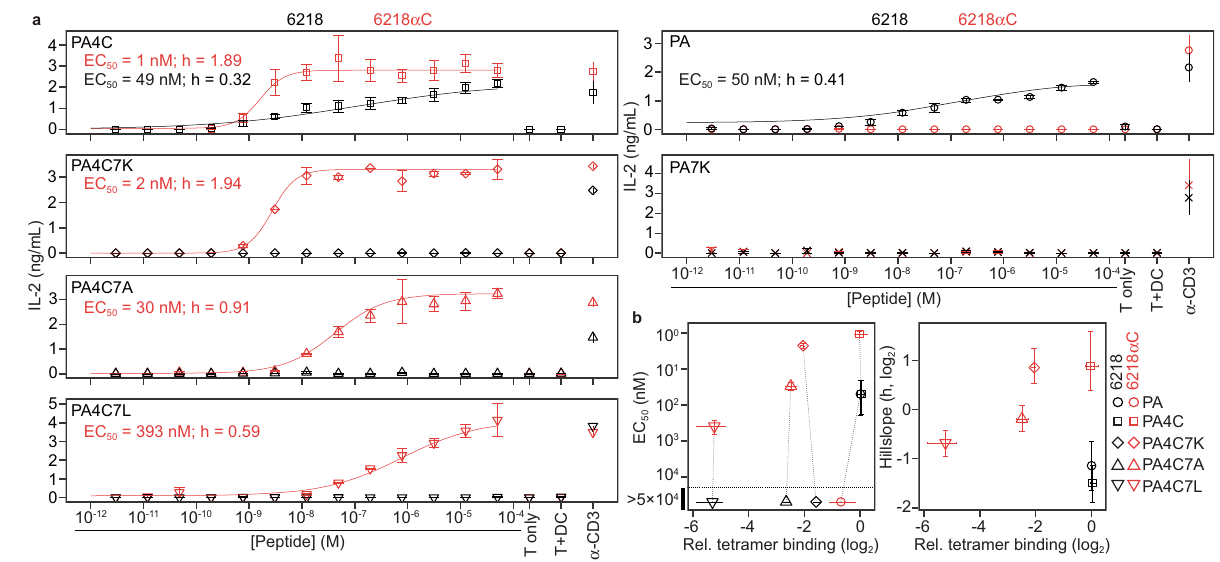
Fig. 8 | T cell activation due to TCR-peptide S-S bonding. a Supernatant IL-2 concentration after coculture of 5KC T cells expressing 6218 or 6218 α C and DC2.4 cells with graded concentrations of the peptide denoted in the upper left of each graph. Control cultures included 5KC cells with 50 μ M peptide (T only), 5KC and DC2.4 cells without peptide (T+DC), and 5KC cells with plate-bound anti-CD3 ( α - CD3). Symbols show the mean, and error bars the range, of 2 wells per condition from oneexperiment, representative ofatleast 2 experiments. HillSlope(h) values were determined using nonlinear regression. For curves that did not reach a